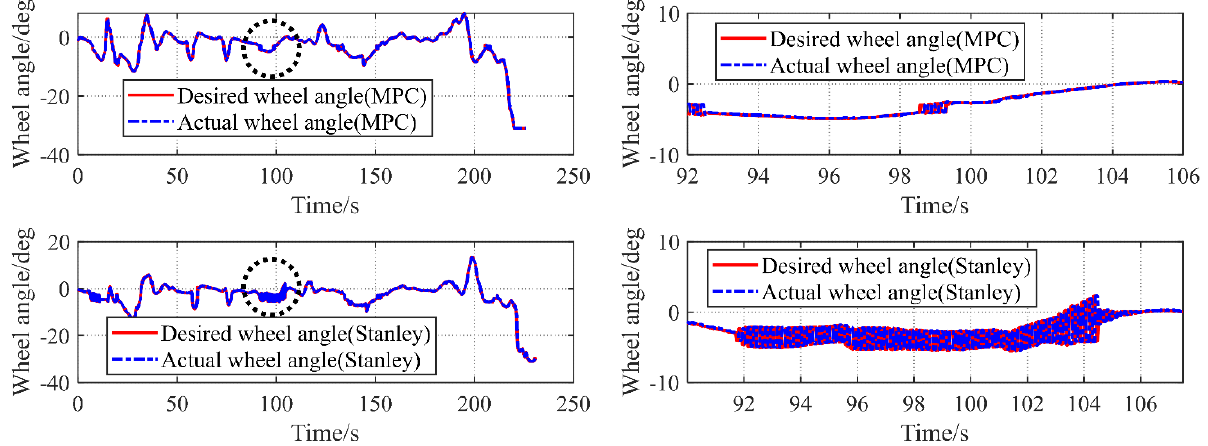
Figure 8. Vehicle wheel angle of MPC control and Stanley control ( left ). Control stability comparison ( right ).